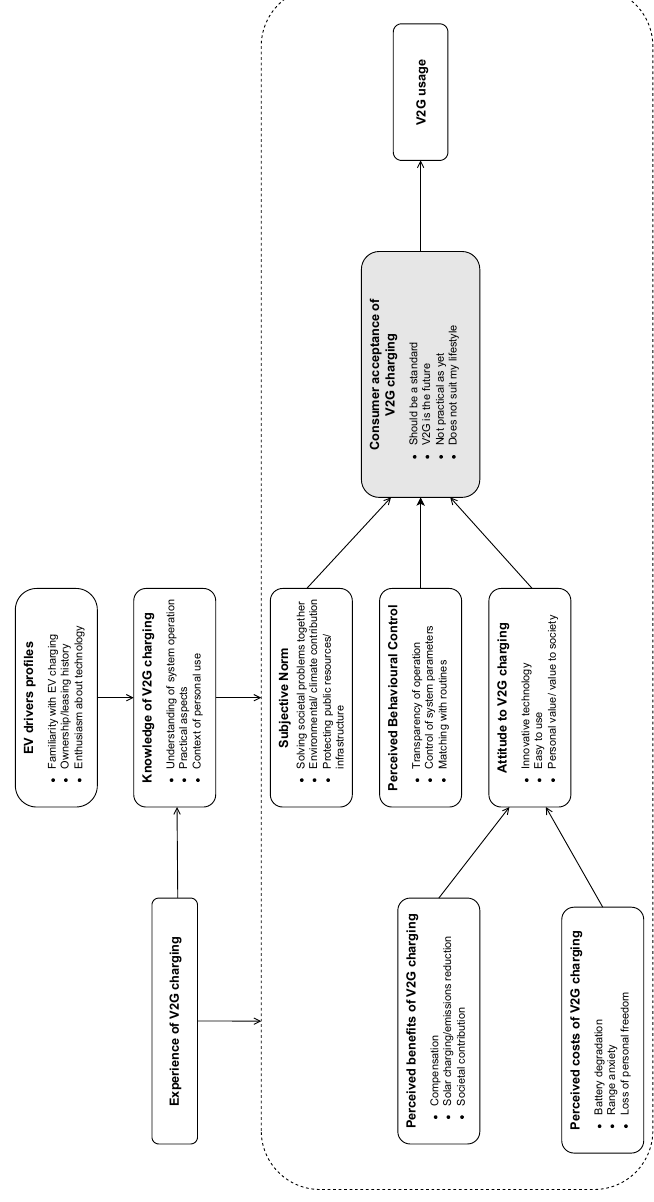
Figure 4. Final model describing the influence of factors on consumer acceptance of V2G. The quantitative estimation of the consumer acceptance of V2G charging is not the goal of this study. As such, the participants were not presented with a Likert-scale or traffic light rating system to fill in their opinions. However, the interview transcripts enable a qualitative interpretation of the degree of acceptance among the participants. These are shown in Table